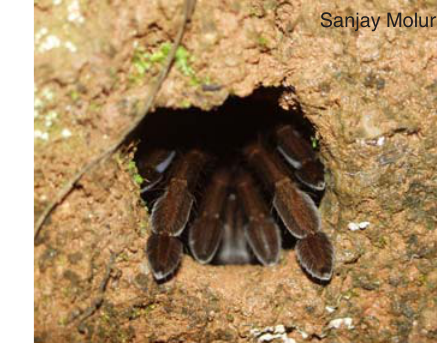
Image 22. Typical burrow-stance of Thrigmopoeus truculentus